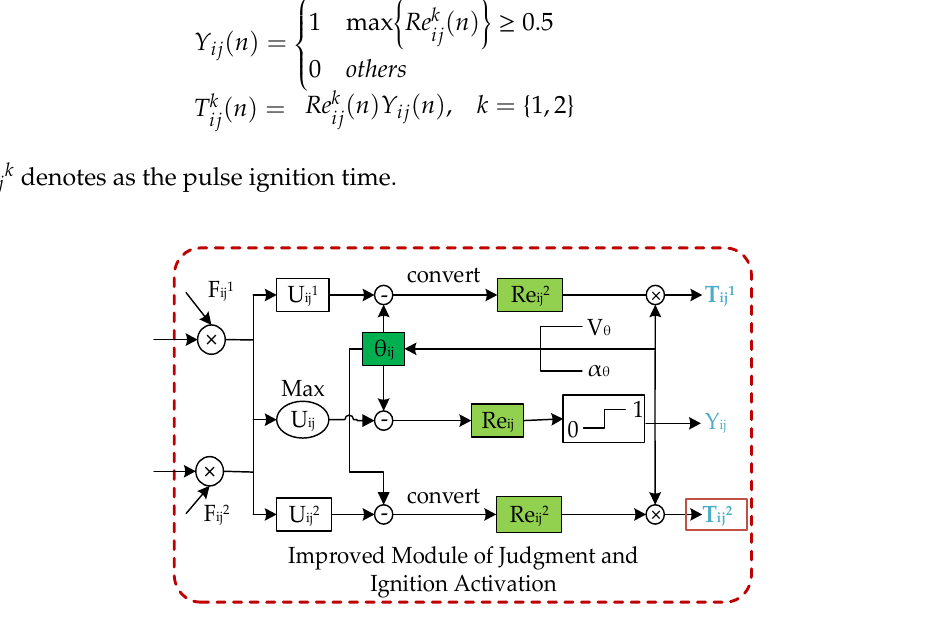
Figure 3. Improved DPCNN model.